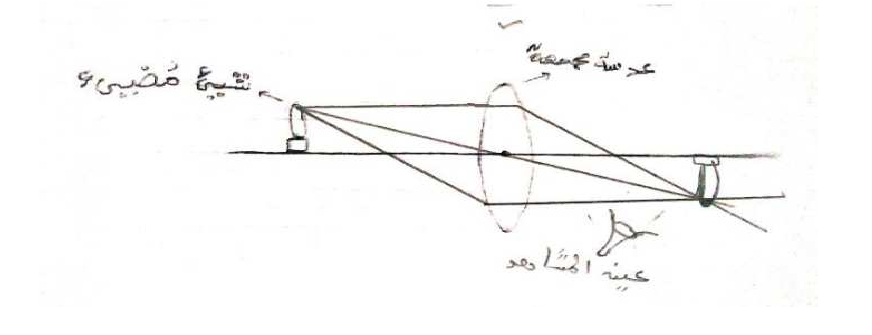
Figure .1 l’emplacement de l’œil de l’observateur, tracé par les élèves.